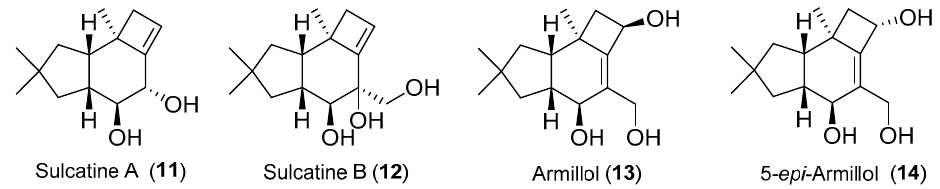
Figure 5. Structures of protoilludanes 11 – 14 isolated from Laurilia sulcate.